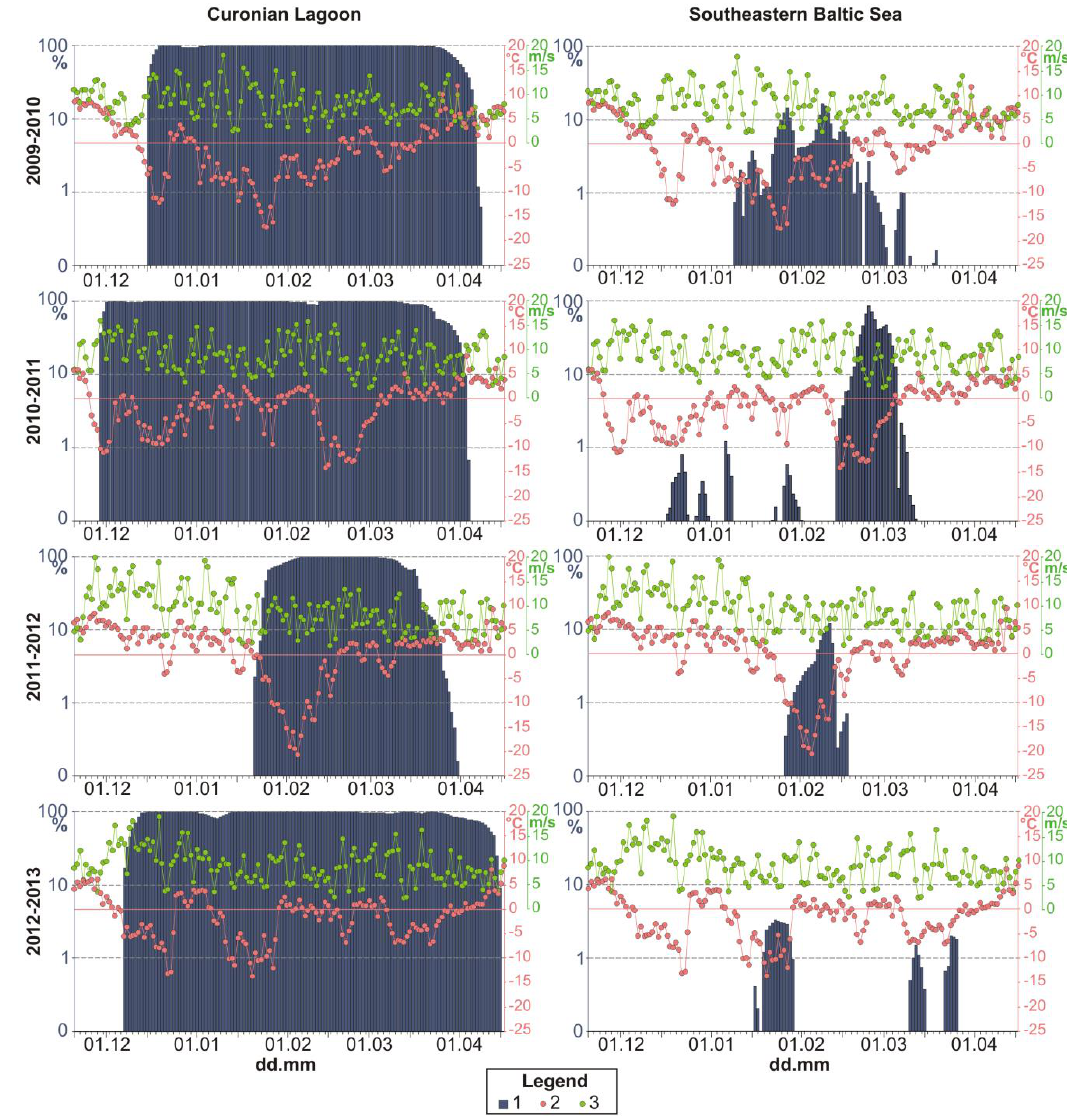
Figure 4. Variability of ice extent in the Curonian Lagoon ( left column ) and in the Southeastern Baltic Sea ( right column ) obtained from satellite data for winters of 2009–2013. Legend: 1—percentage of the ice extent within the study area; 2—daily average air temperature (Ta); 3—daily average wind speed. Zero values in both diagrams mean absence of ice cover.